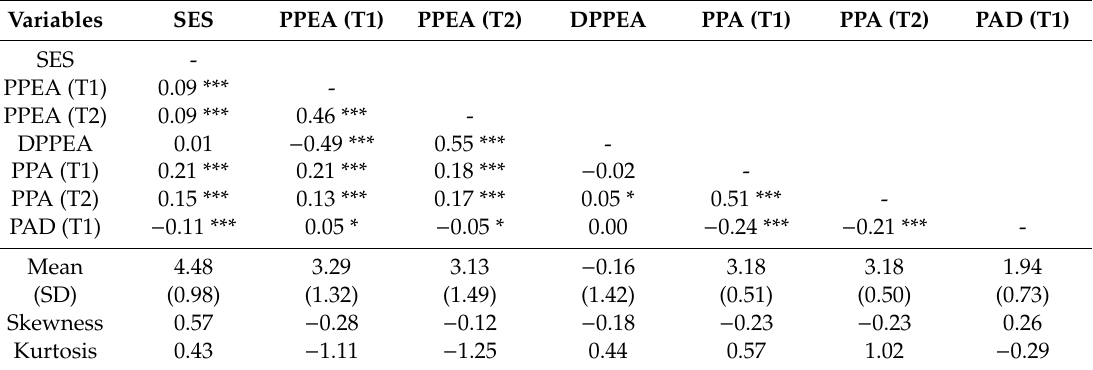
Table 3. Correlation and statistical analyses of observed variables for Cohort